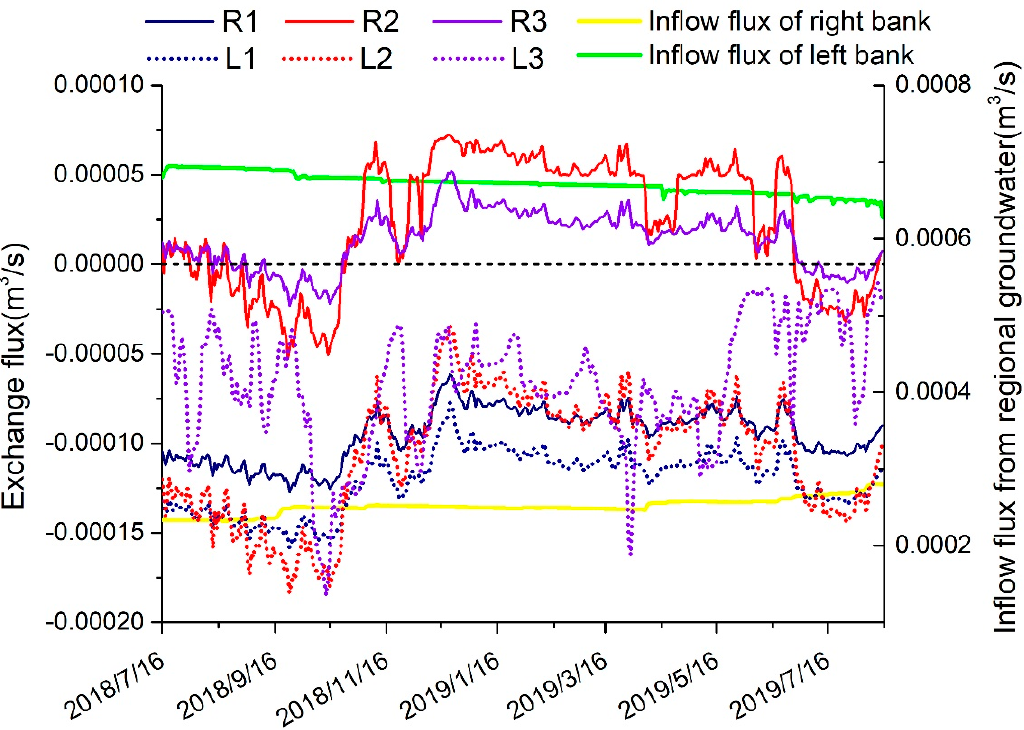
Figure 9. Exchange flux between the river and the wetland at points during the simulation period (positive value represented that the groundwater is recharging the river, negative value indicated that the river supplies groundwater); inflow flux of both banks from the regional groundwater flow.